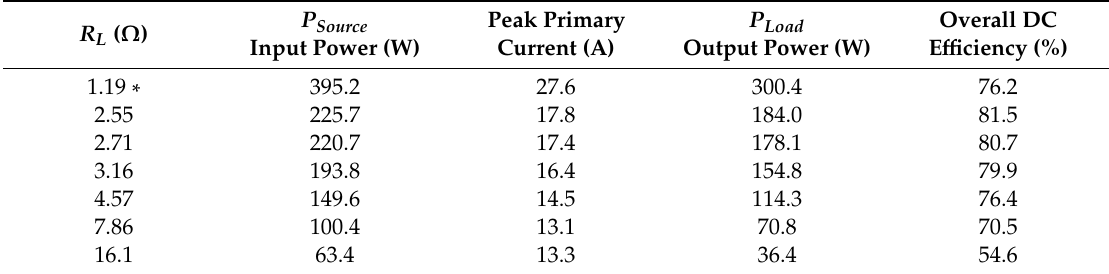
Table 3. Main system’s input and output power values.